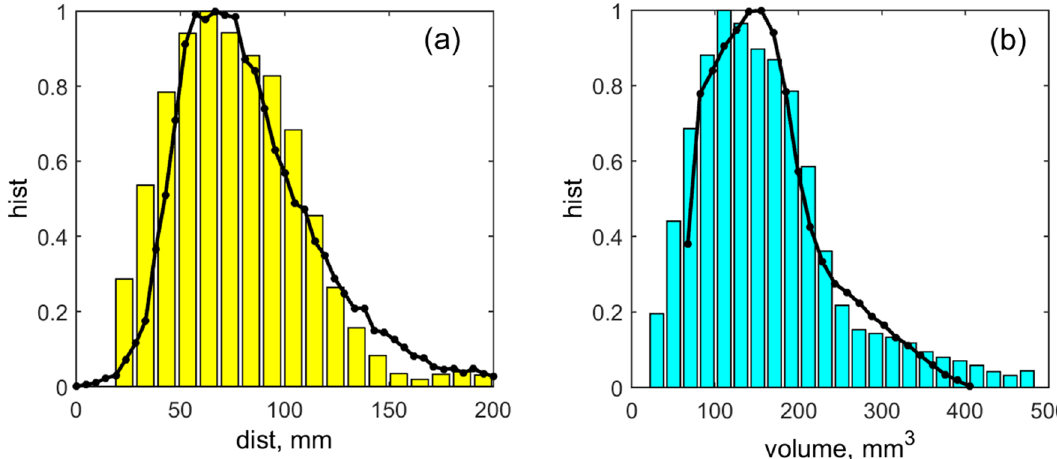
Figure 4. The comparison between the numerically (curves with points) and experimentally (bars) obtained data. The subplot ( a ) shows the histogram of the distances between nearest neighbors and the subplot ( b ) presents the histograms of the volumes of the animals (which are supposed to be approximately proportional to their